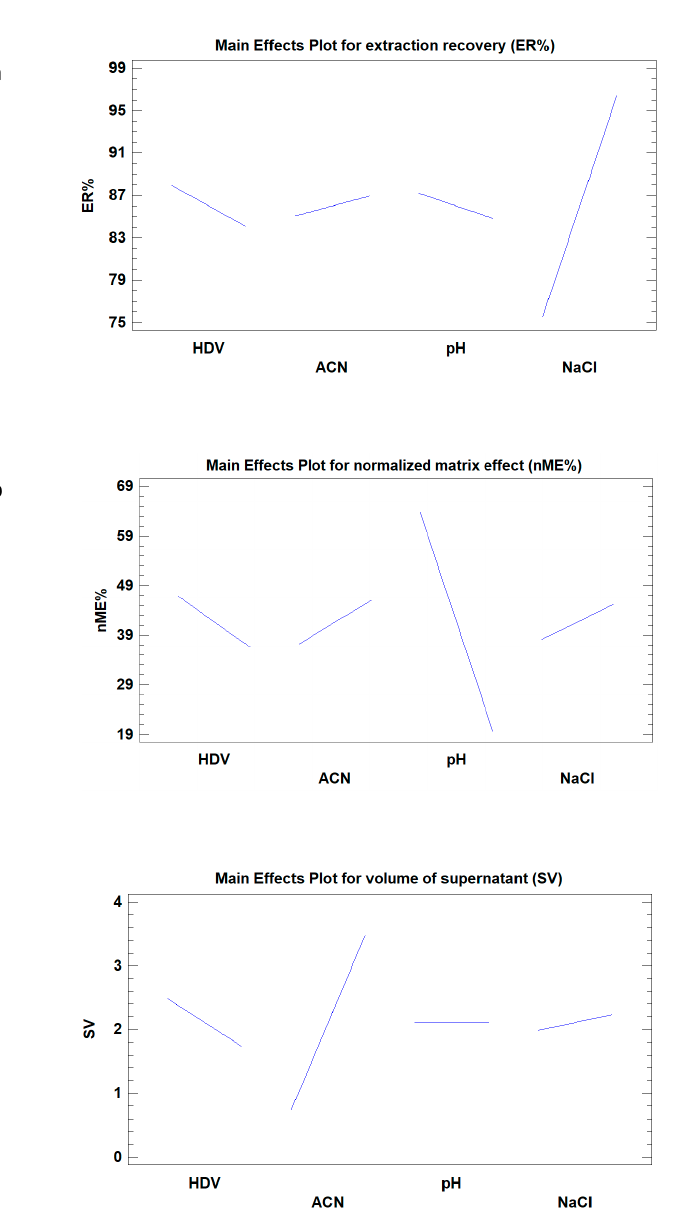
Figure 1. Main e ff ect plot of the three response factors: ( a ) Extraction recovery (ER%), ( b ) normalized matrix e ff ect (nME), and ( c ) supernatant volume (SV), on the four controllable variables: (HDV) honey-diluted volume (mL), extraction solvent volume (ACN), pH, and NaCl percentage of the honey